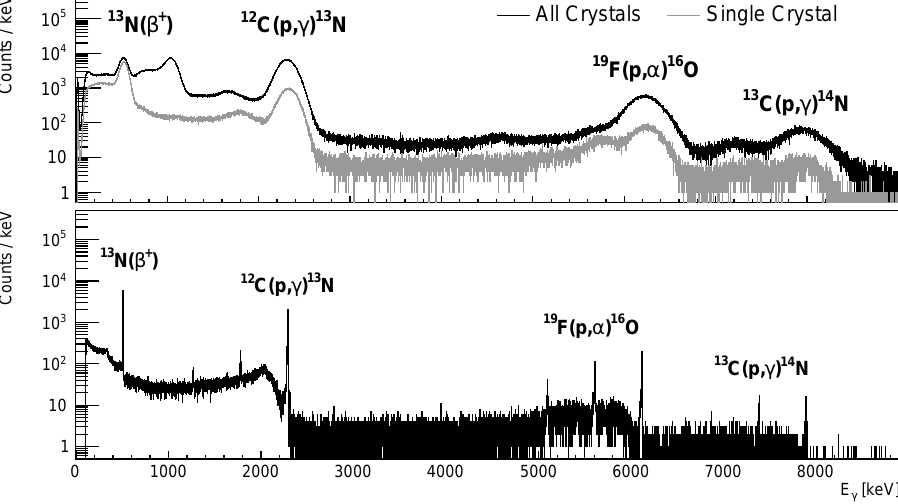
Figure 3: Examples of the spectra acquired at E p = 380 keV. The upper panel shows the spectrum from the BGO. The lower panel shows the HPGe